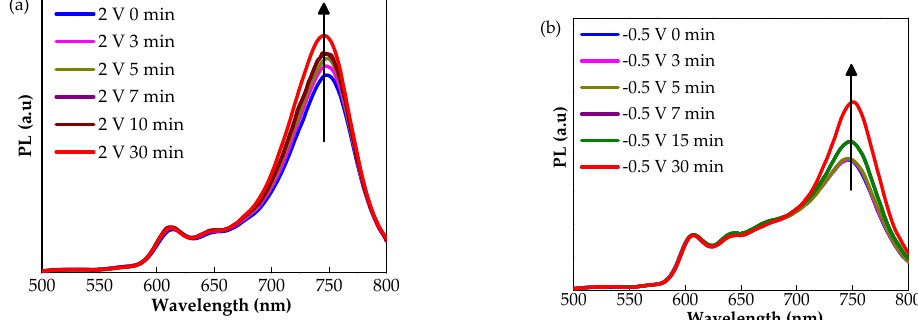
Figure 7. PL spectra of electric field modulated quasi-2D perovskite solar cells. ( a ) different modulation time at the forward bias of 2 V. ( b ) Different modulation time at the reversed bias of − 0.5 V.